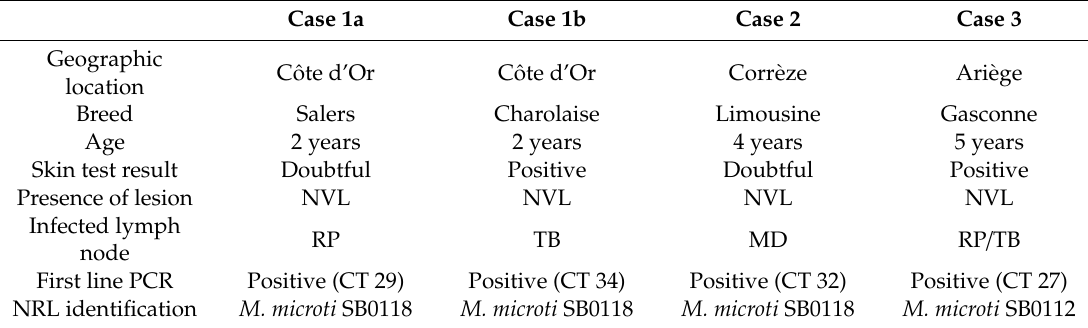
Table 3. Description of M. microti